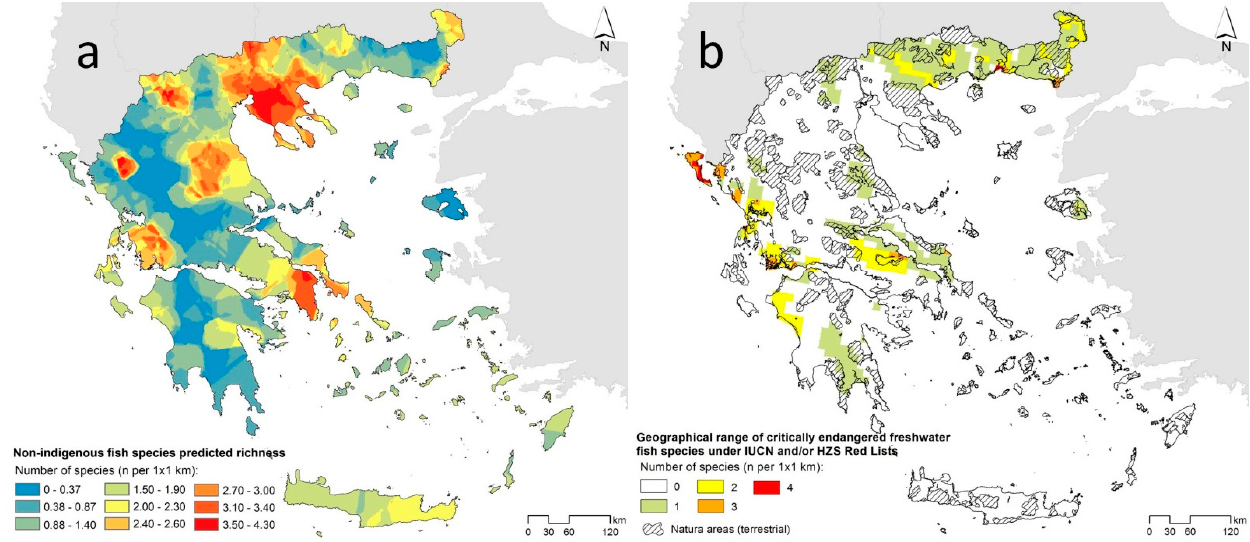
Figure 4. ( a ) Patterns of predicted richness of non-indigenous fish species (indicating high invasion pressure) and ( b ) geograph- ical distribution range of critically endangered freshwater fish species and protected areas (Natura 2000